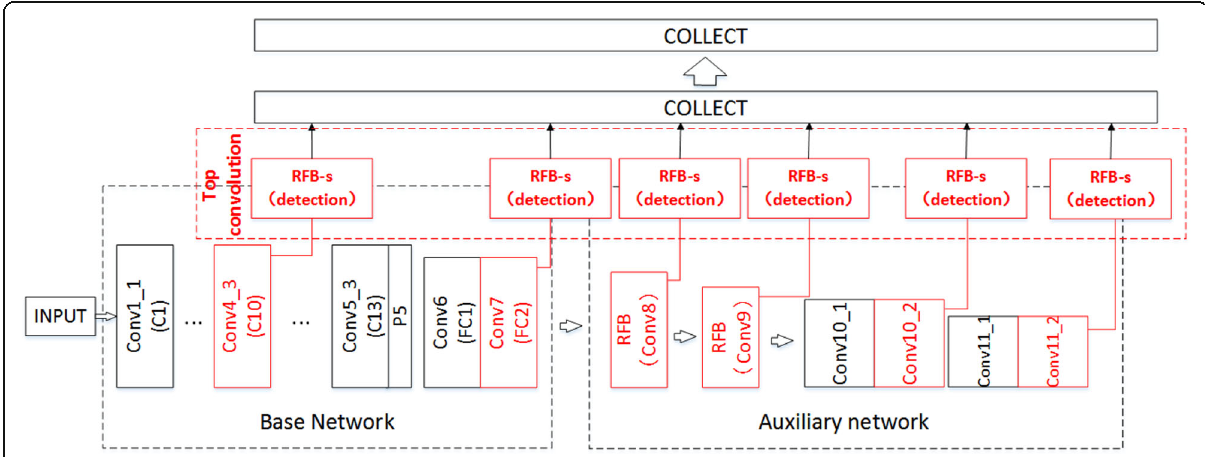
Fig. 4 The network structure of RFB Net. Conv8, Conv9, and the top convolution layer in Fig. 2 are replaced with RFB module, and connected with Conv4_3 is the RFB-s